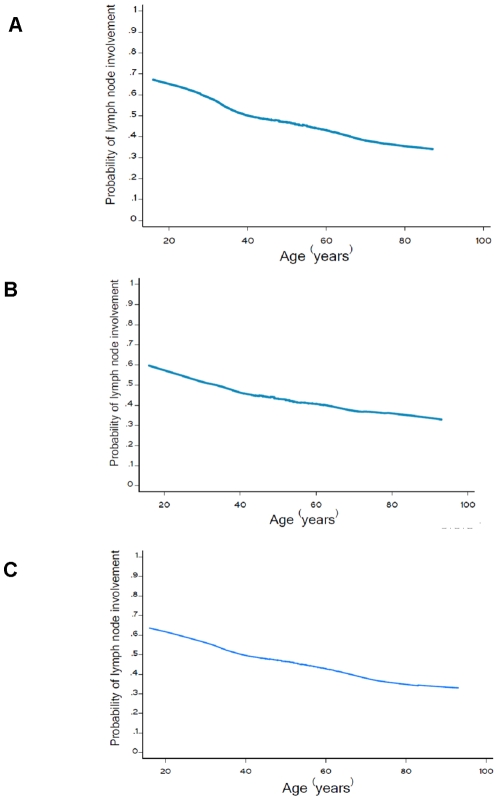
Relation between age and lymph node involvement based on univariate nonparametric smoothing method.(A) The first dataset using univariate nonparametric smoothing method (n = 3,715) (B) The second dataset using univariate nonparametric smoothing method (n = 1,832) (C) The combined two datasets using univariate nonparametric smoothing method (n = 5,547).